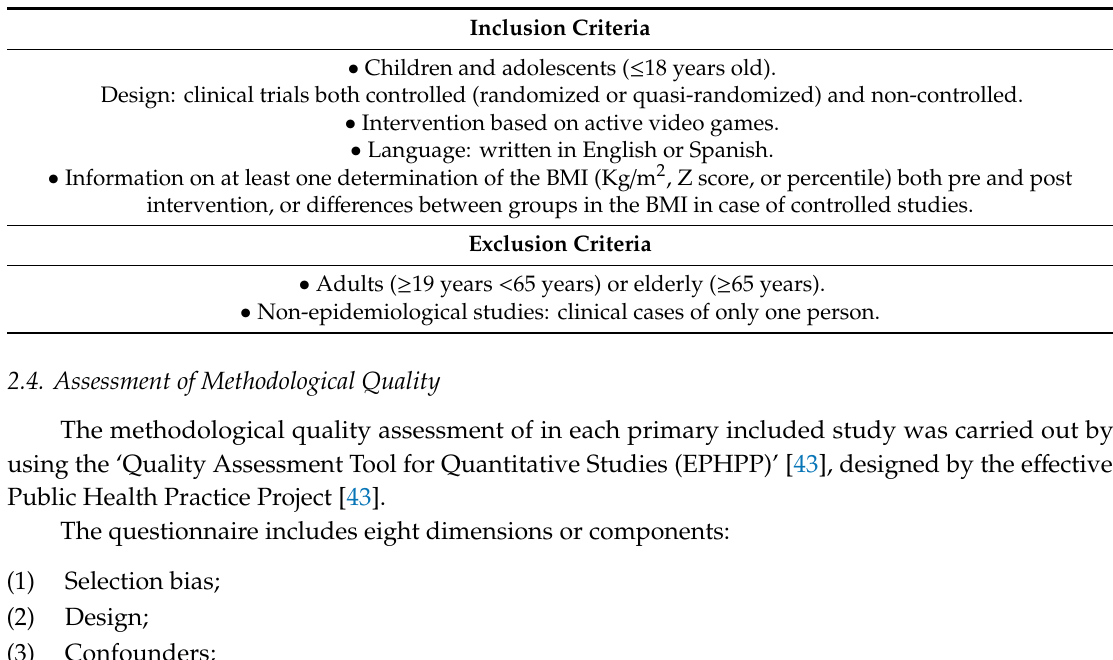
Table 1. Inclusion and exclusion